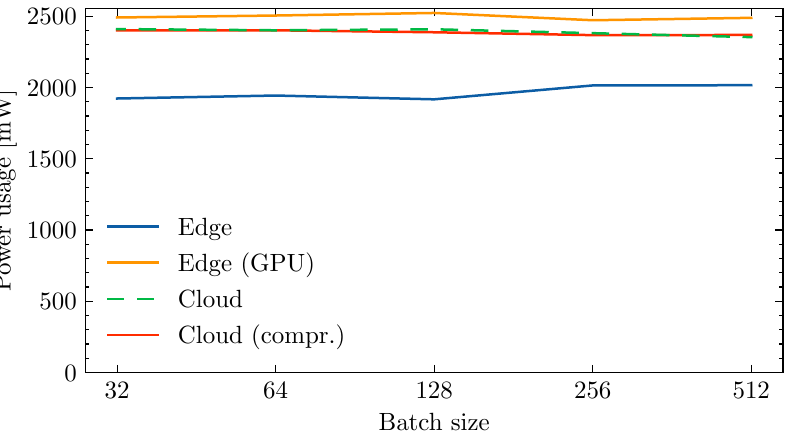
Figure 4. The mean power consumption of the edge device for different approaches and batch sizes confirms that edge computing is beneficial for reducing power